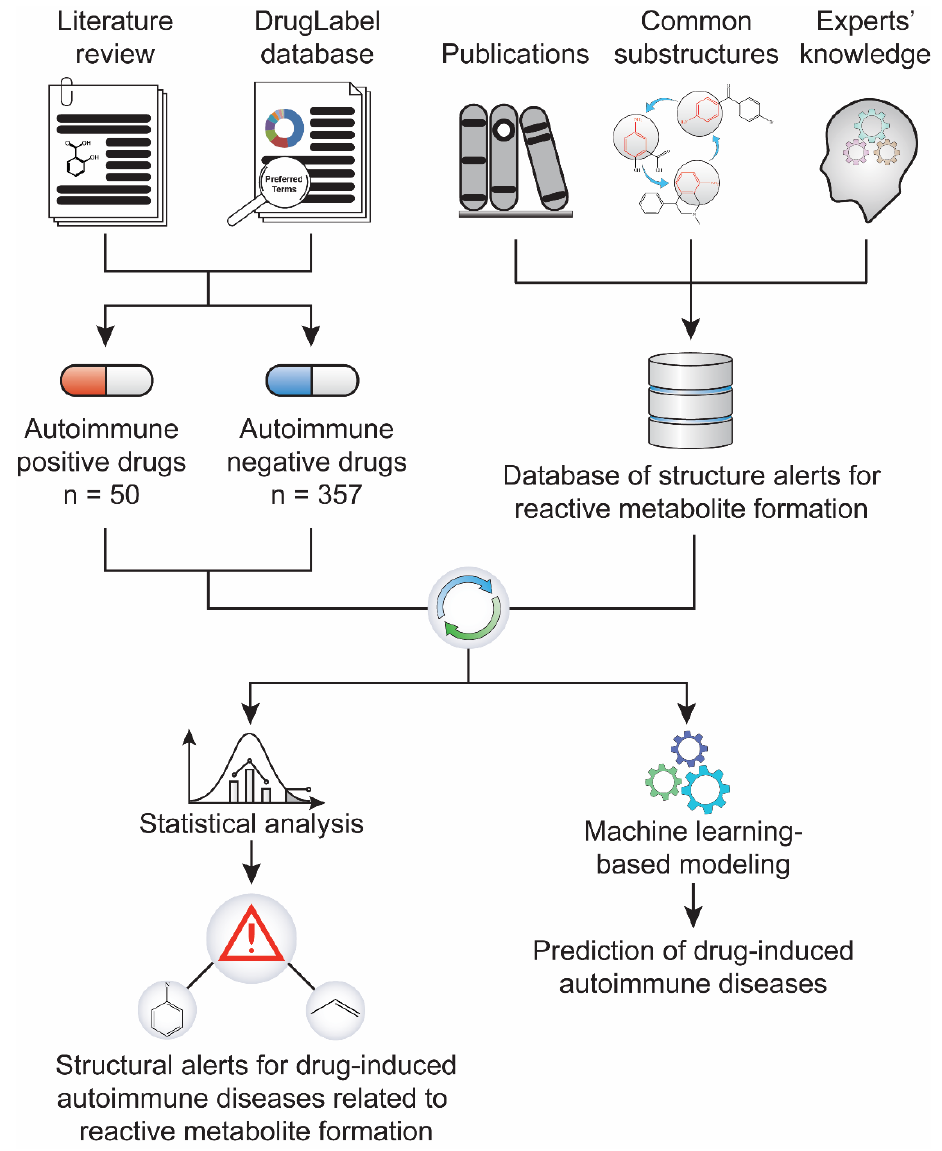
Figure 1. Study workflow. A dataset of 407 drugs, including 50 positives for drug-induced autoimmune disease (AD) and 357 negatives, was compiled through literature text mining and the FDA’s drug label database. In parallel, a library of 171 structural alerts for reactive metabolite formation was collected from literature. The statistical association between the reactive metabolite-related structural alerts and drug-induced ADs was analyzed.